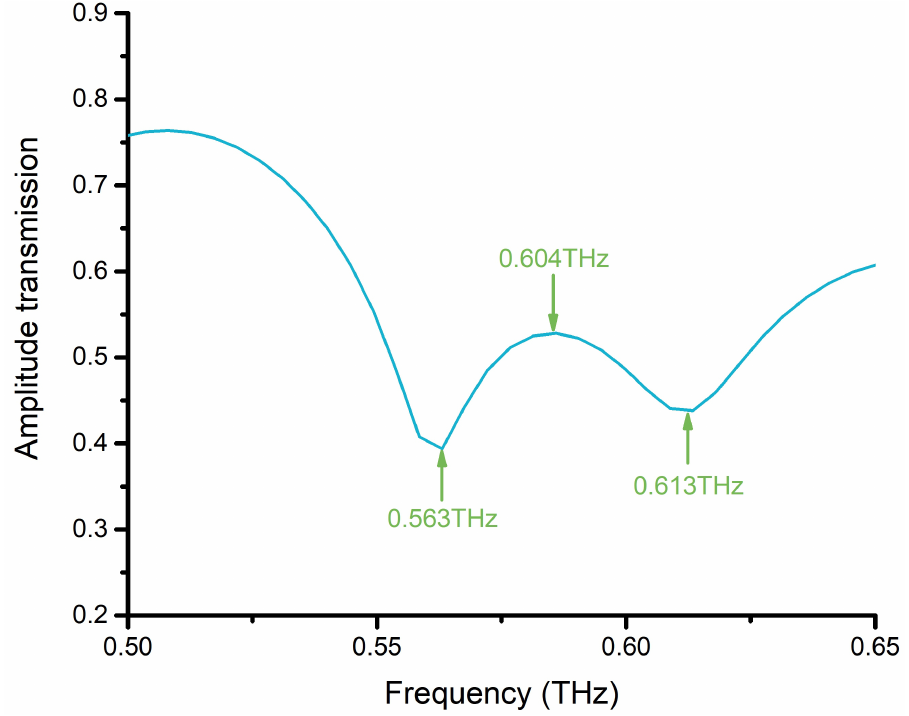
Figure 9. The amplitude transmission of the bare metamaterial sensor